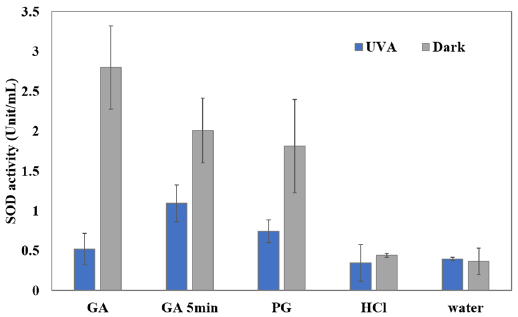
Figure 4. Superoxide dismutase activity (Unit/mL) of E. coli O157:H7 suspensions treated by UV-A light and selected compounds. E. coli O157:H7 was treated by GA (15 mM), PG (10 mM), HCl (pH = 3.1), or water for 30 or 5 min. Mean ±